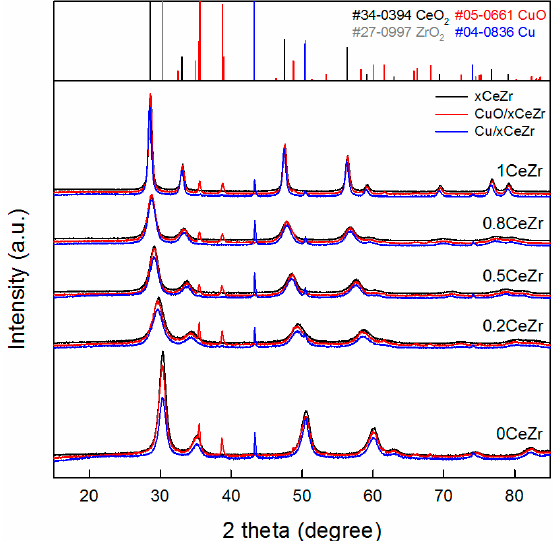
Figure 1. Powder X-ray diffraction patterns of x CeZr (black), calcined CuO/ x CeZr (red), and reduced Cu/ x CeZr (blue) samples. The reflections of CeO 2 (black bars), ZrO 2 (gray bars), CuO (red bars), and Cu metal (blue bars) are included for peak identification.